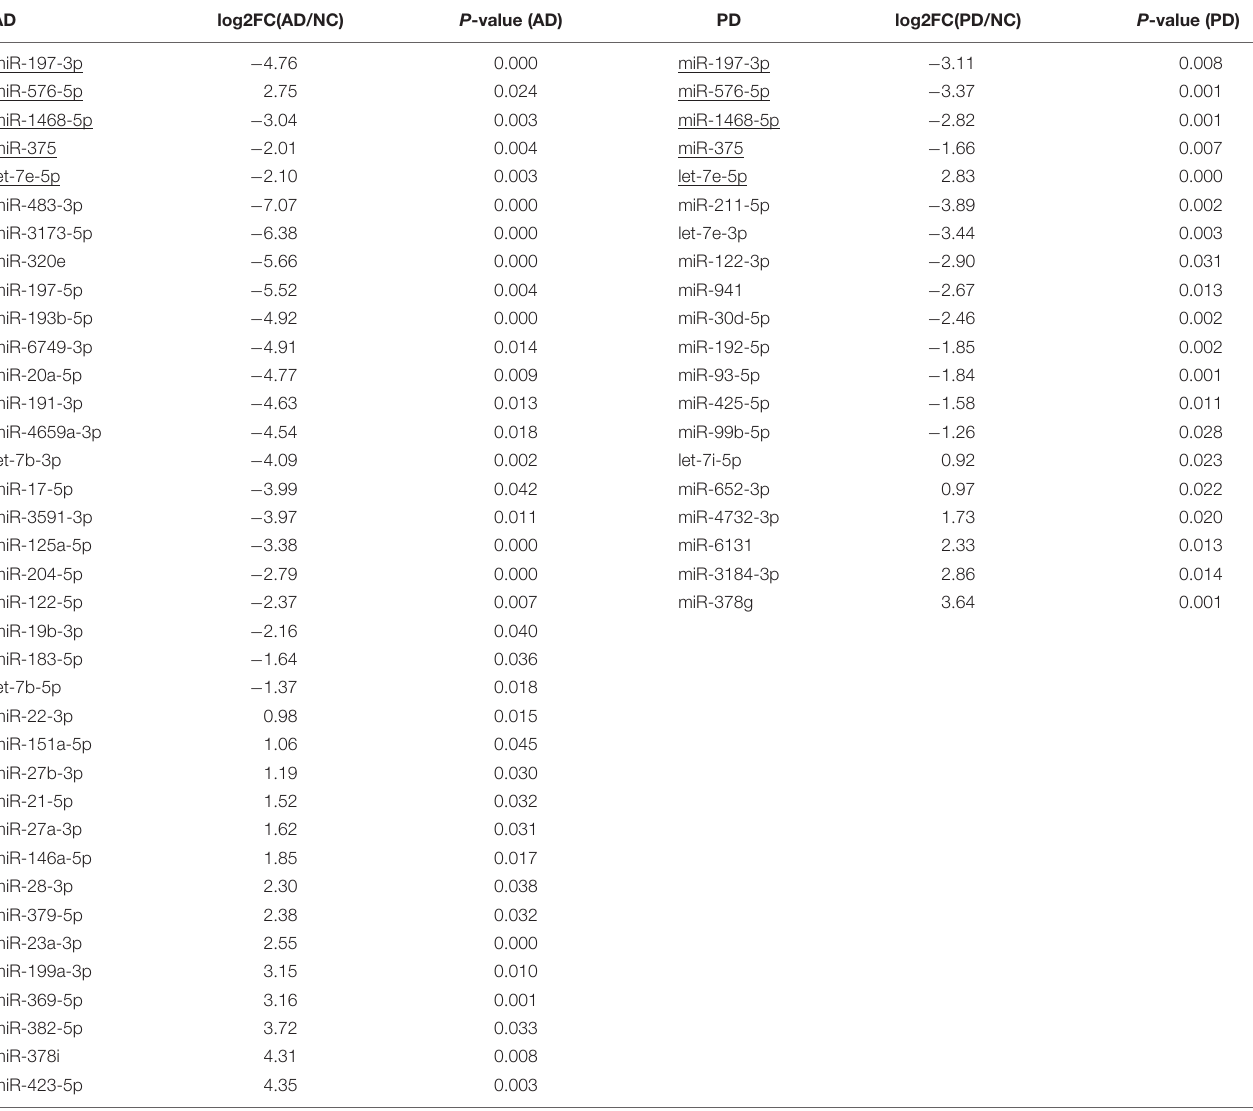
TABLE 1 | Differential expressed exo-miRNA in AD and PD